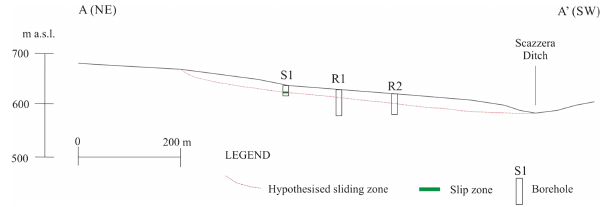
Figure 3. Topographic profile (trace A–A’ in Fig. 1) with the hy- pothesised trend of the sliding